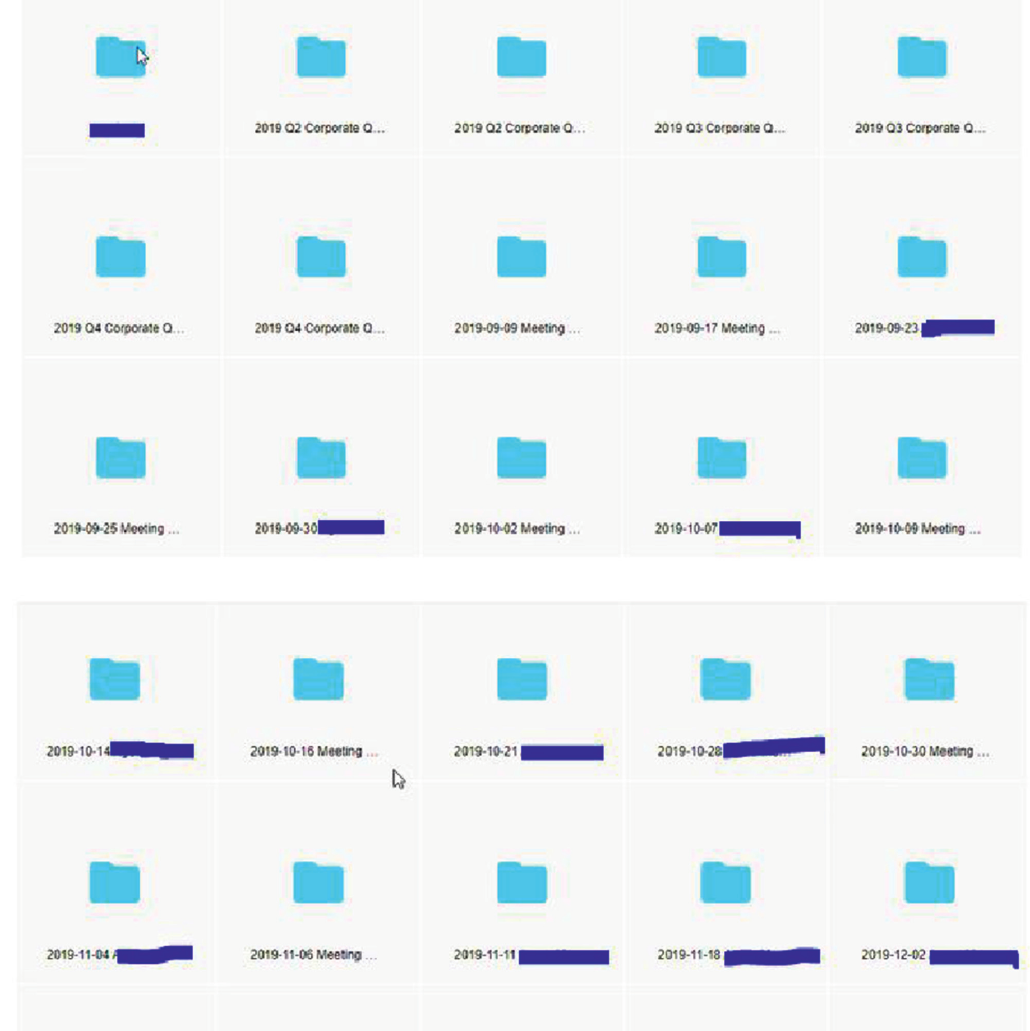
Figure 8: A screen shot folders of files from “10x Genomics” hacked by REvil attacker